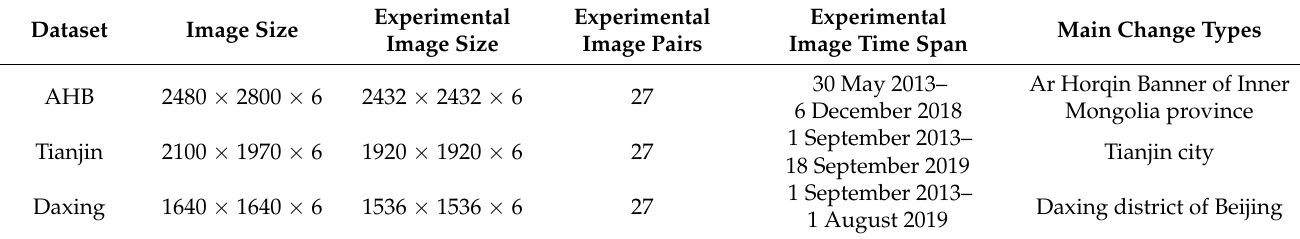
Table 1. The experimental dataset